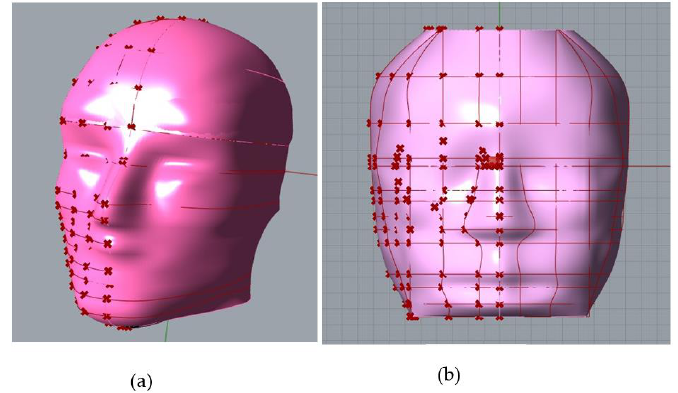
Figure 13. ( a ) Parametric standard head; ( b ) User’s parametric head modelling.